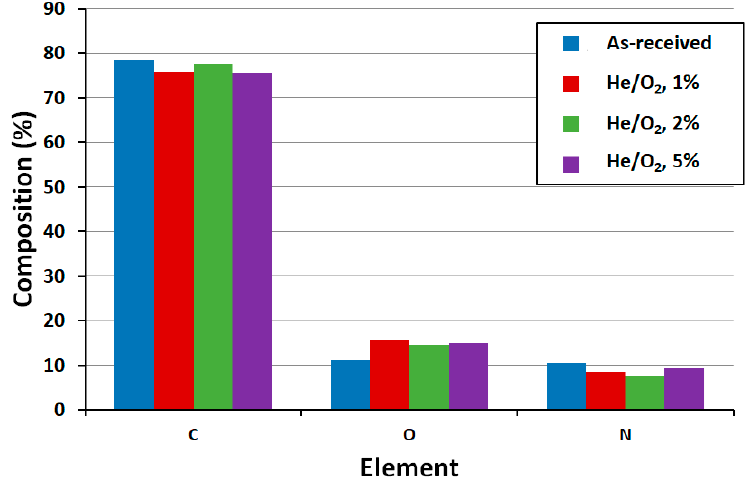
Figure 9. Surface composition represented by the atomic percentages of carbon (C), oxygen (O) and nitrogen (N) of the nylon surface after He/O 2 plasma treatment for 180 s. Table 1. Composition of as-received and plasma-treated nylon surfaces, as represented by the atomic percentages of carbon (C), oxygen (O) and nitrogen (N); and their relative ratios including C/O, C/N and O/N.